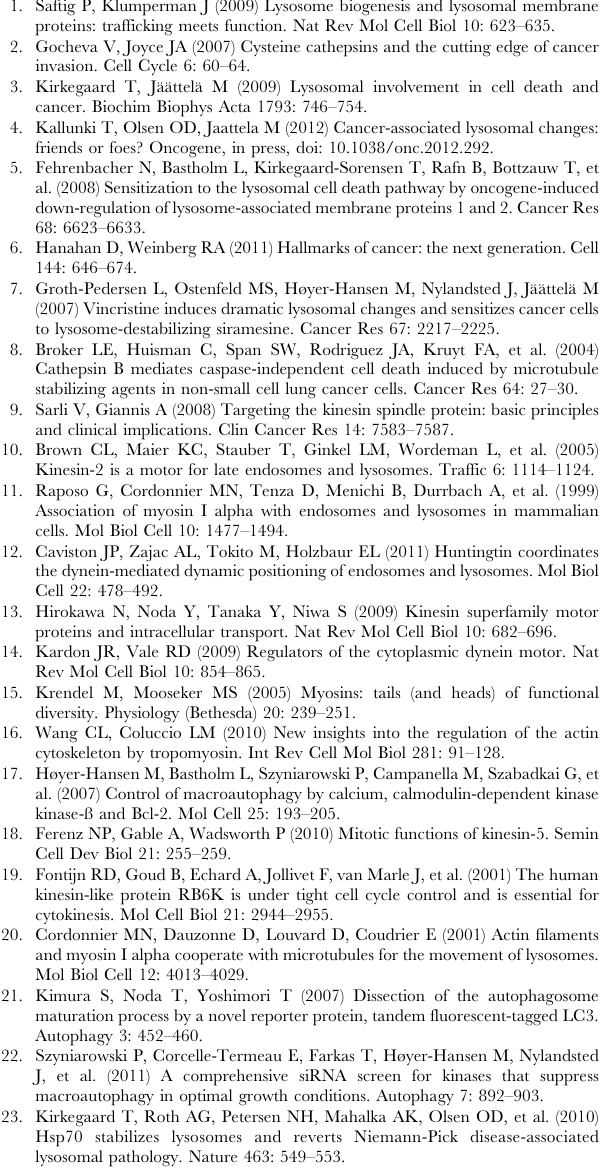
Figure S1 Validation of the identified cell death-induc- ing siRNAs by RT-PCR and Western blot. (TIF) Figure S2 The KIF11 inhibitor monastrol sensitizes cancer cells to siramesine.